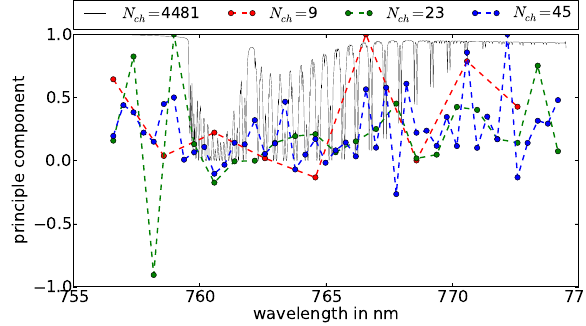
Fig. 7. Similar to Fig. 5, but the positions of the spectral channels were chosen with the optimization technique based on the minimization of C matrix residuals.